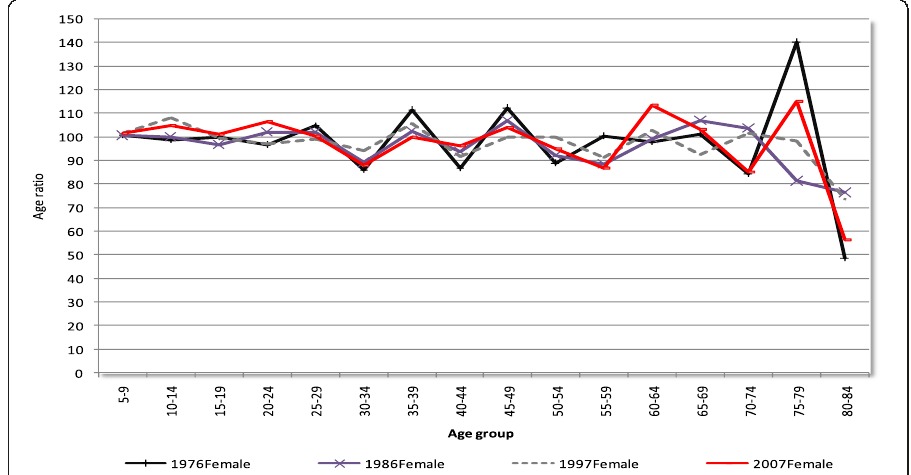
Fig. 4 Age ratio of females for 5-year age groups, Swaziland, 1976 – 2007 PHC. Source: published raw data from Swaziland